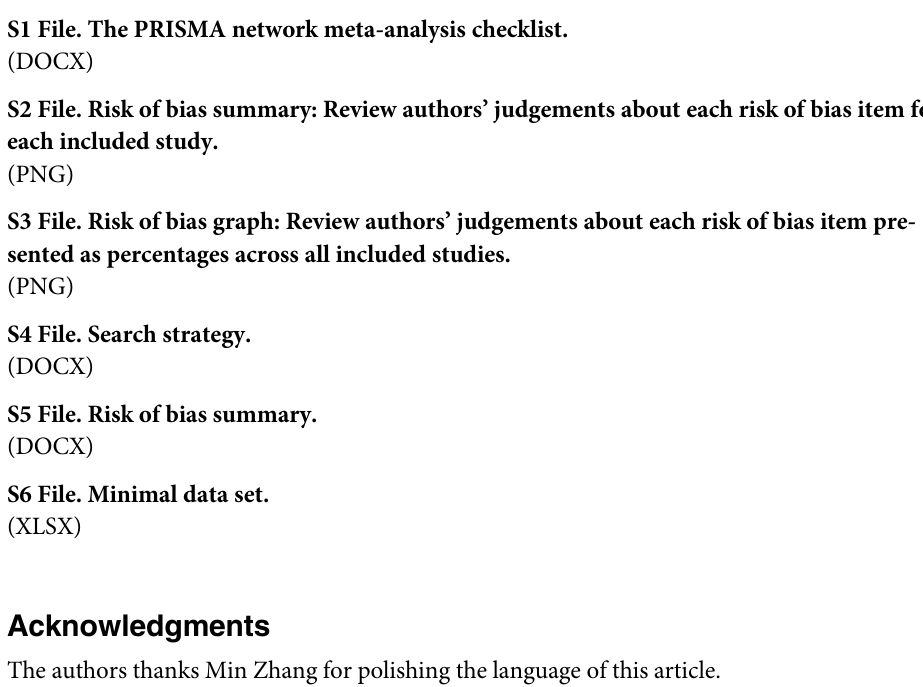
S1 Table. Characteristics of the included